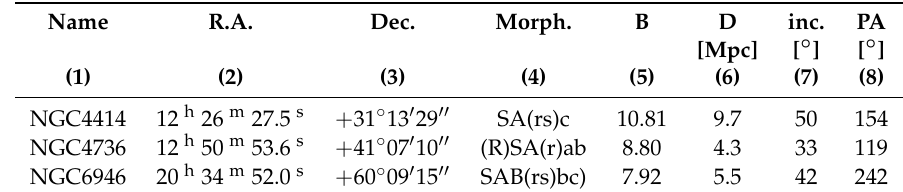
Table 1. Basic Parameters of Samples.